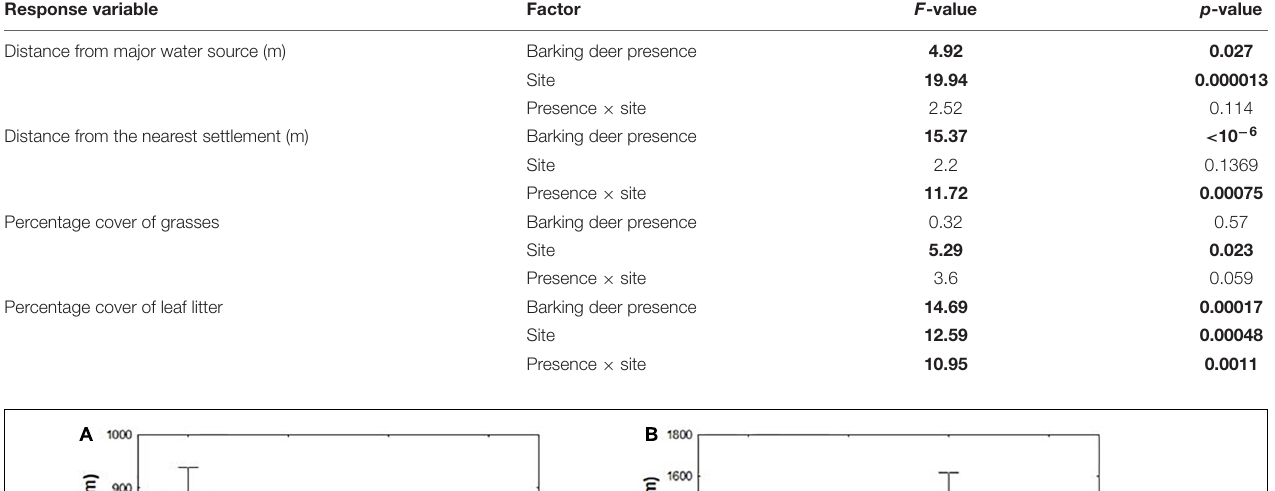
TABLE 3 | Results of the 2-way factorial ANOVAs with factors “ barking deer presence ” and “ site ” for the response variables distance from major water source, distance from the nearest settlement, percentage cover of grasses and percentage cover of leaf litter; significant values ( p < 0.05) are in boldface. Response variable